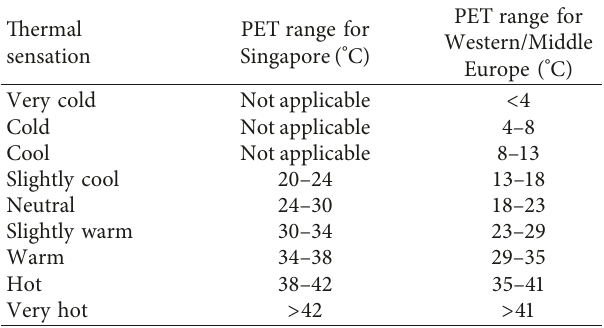
Table 4: Thermal sensations and PET classes for Singapore and Western/Middle Europe.